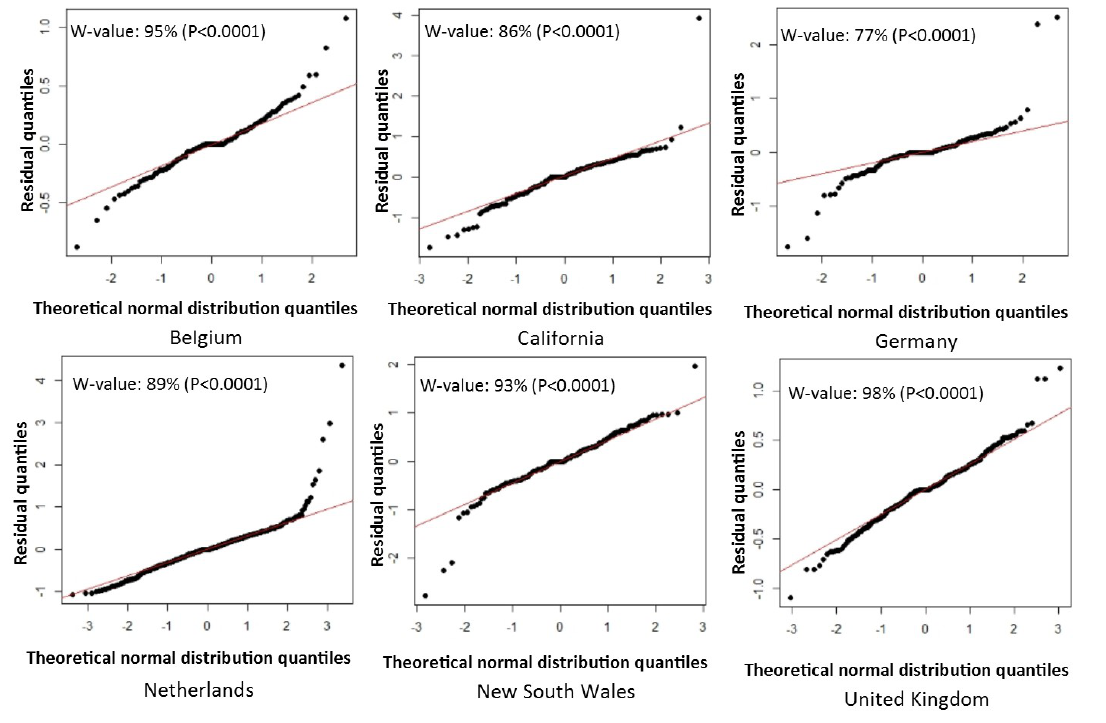
Figure A2. The Q-Q plots of residuals of countries and regions in Table 3 for shading group. W-value: The percentage number from Shapiro-Wilk’s W test. P: p value reports the statistical significance of the test.